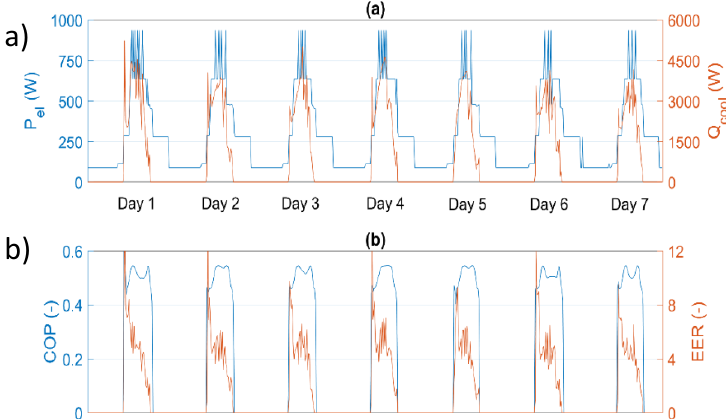
Figure 7. Performance results of proposed system prototype with respect to ( a ) the produced cooling output and the respective electrical consumption and ( b ) the corresponding coefficient of performance (COP) and energy efficiency ratio (EER) values.